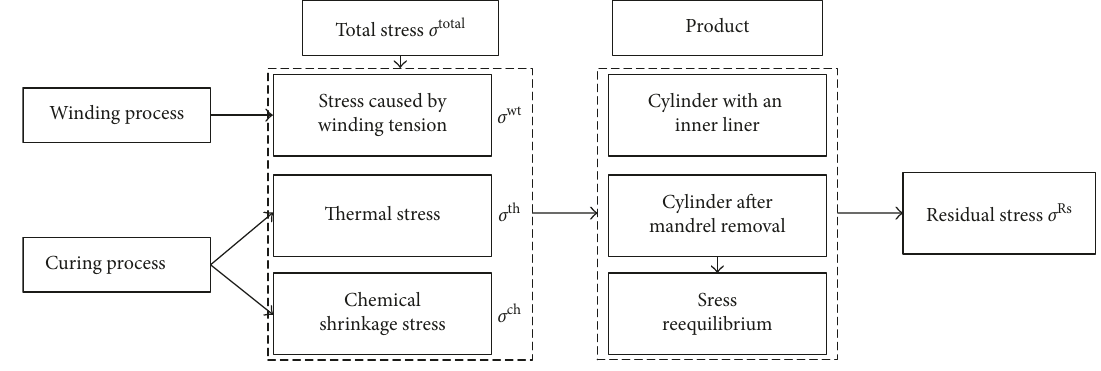
Figure 2: The solving procedure of residual stresses.